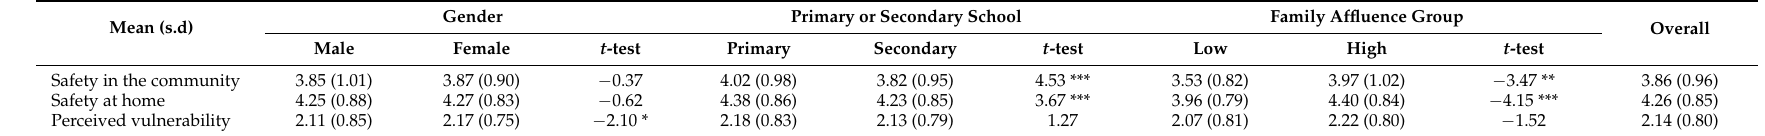
Table 5. The impacts on perceived vulnerability and safety by groups with independent t -test ( N =